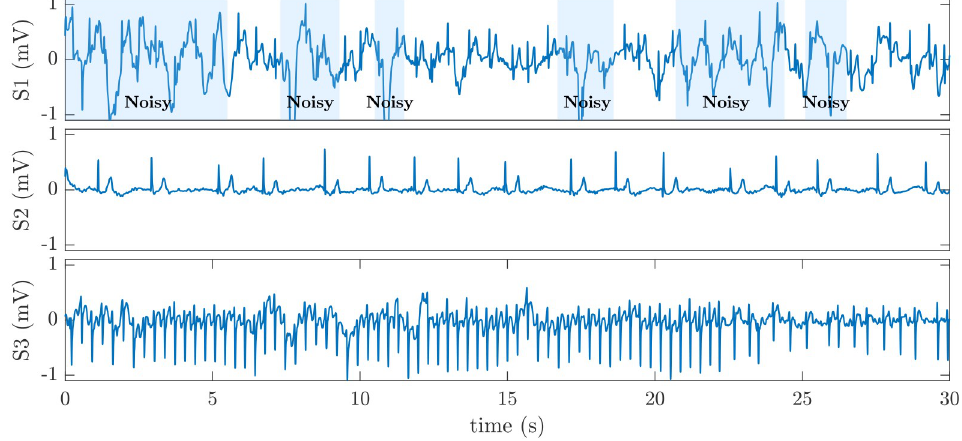
Fig 3. Examples of false-negative errors in AFib detection. S1 is a 30 s noisy ECG segment in the test dataset labeled as AFib but incorrectly classified as non-AFib. S2 is a slow AFib rhythm with a 34 bpm ventricular rate that is classified as non-AFib. S3 is a segment of AFib with supraventricular tachycardia (SVT) that is incorrectly classified as